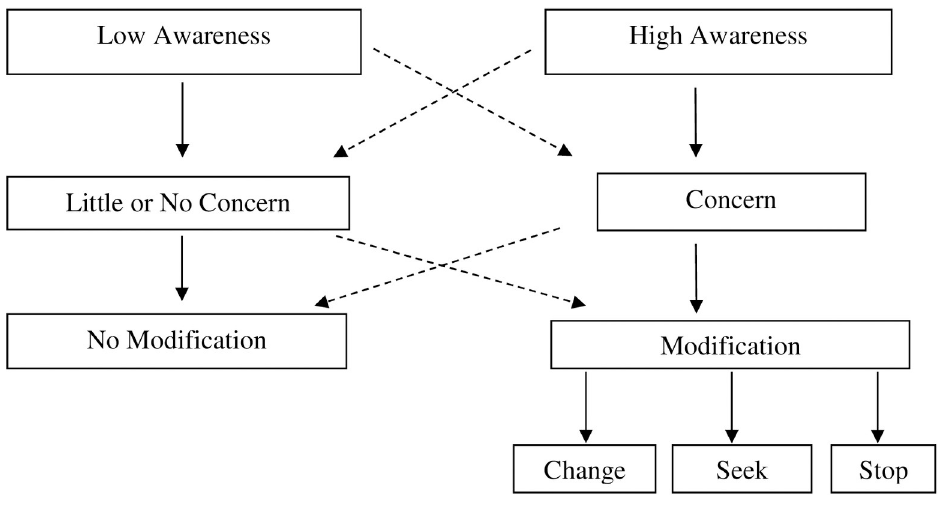
Fig 1. Model of awareness and behavior